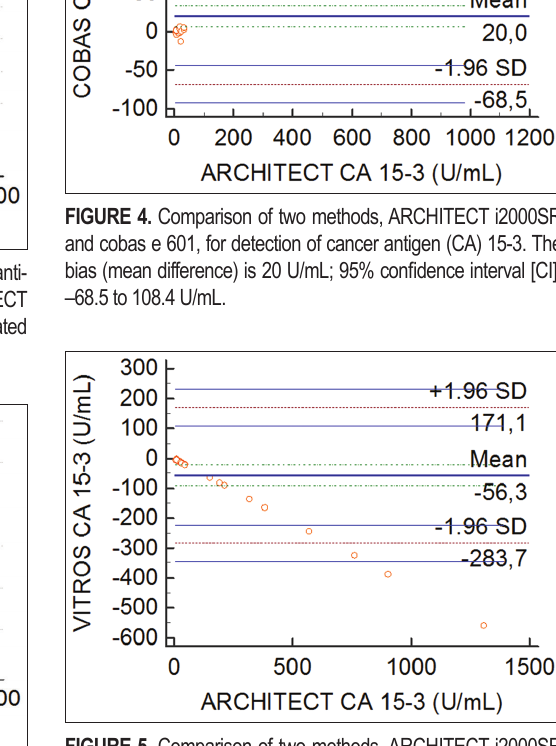
FIGURE 5. Comparison of two methods, ARCHITECT i2000SR and VITROS 5600, for cancer antigen (CA) 15-3 detection. The bias (mean difference) is -56.3 U/mL; 95% confidence interval [CI], –283.7 to171.1